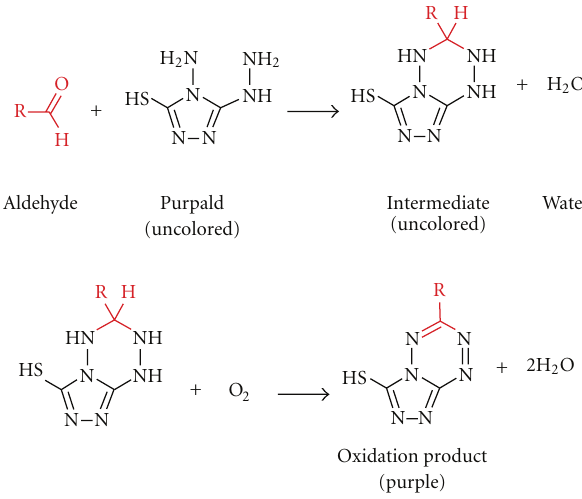
Figure 2: Reaction mechanism for the determination of aldehydes using purpald according to Hopps